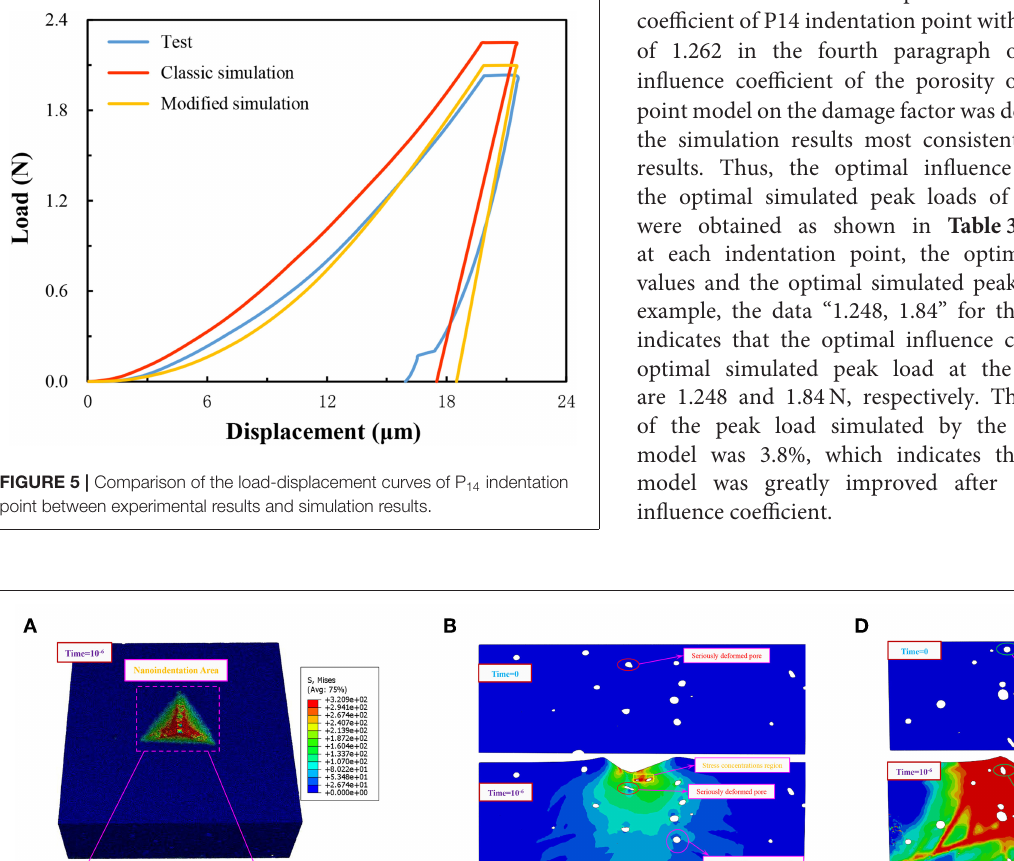
Frontiers in Materials |